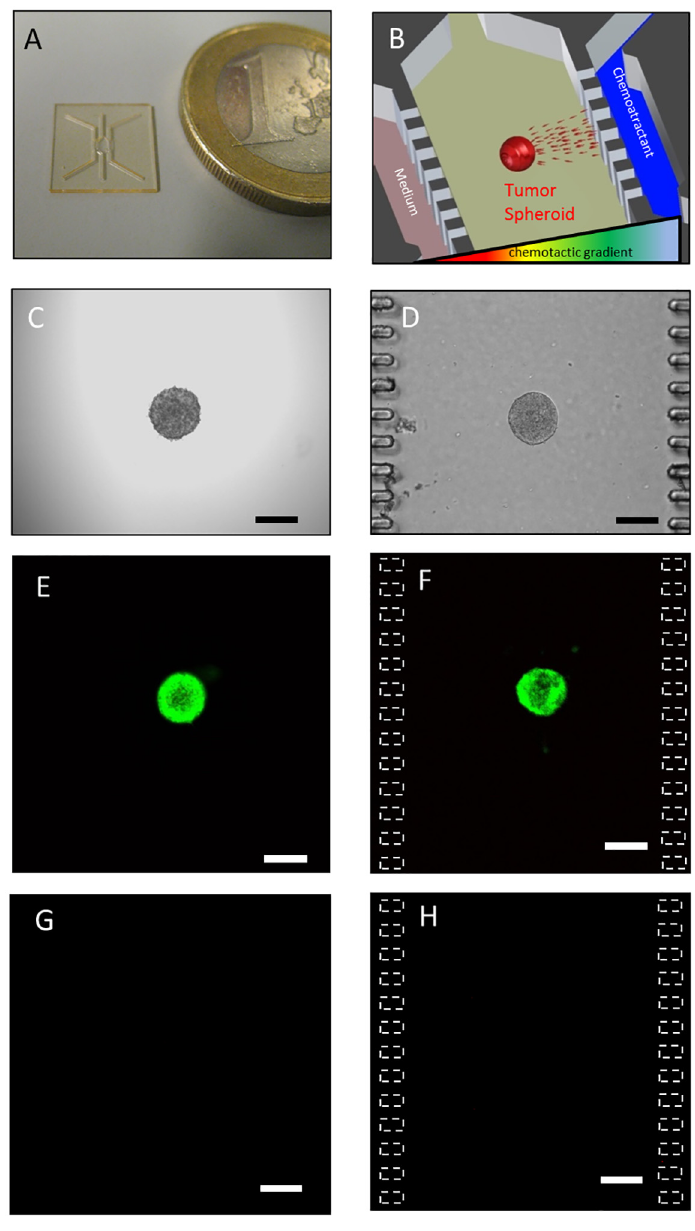
Fig 1. Experimental set-up. (A) SU – 8 fabricated microdevice. (B) Experimental scheme. (C) OSC – 19 spheroid of 2000 cells in the hanging drop. (D) Same spheroid after embedding in 1.5 mg/ml collagen hydrogel within the microdevice. Treatment of the spheroids with FDA/PI after 48 hours in a hydrogel in a 96-well plate or within the microdevice shows the spheroid is intensely green (E and F respectively) whereas less than five red cells where observed (G and H respectively), Z projection of the whole spheroid is shown. Scale bar is 200 μ